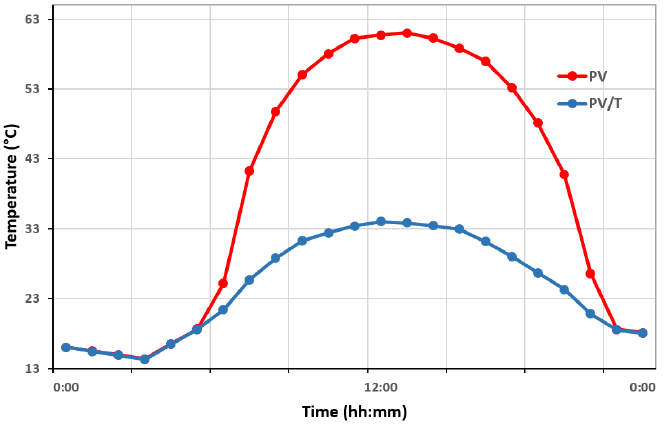
Figure 8. Comparison of PV and PV/T temperatures.